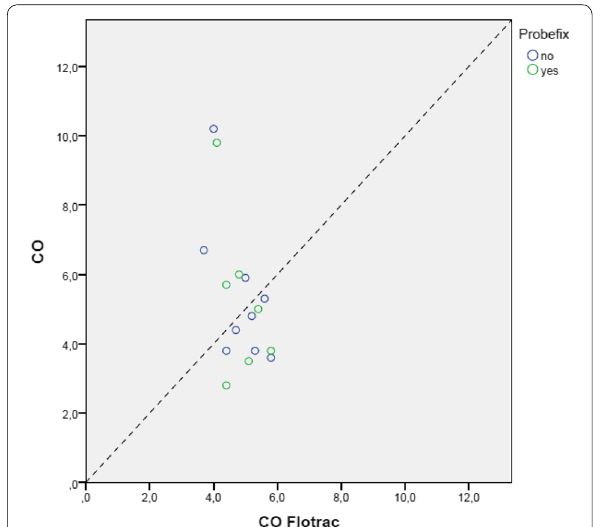
Fig. 6 Scatter plot transthoracic echo (TTE) cardiac output (CO) vs. Flotrac with (green points) and without the use of Probefix (blue